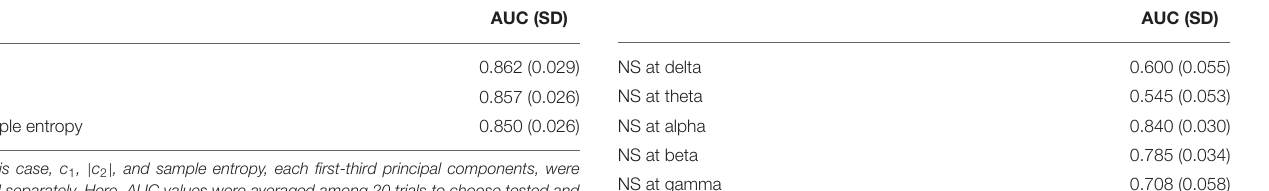
TABLE 5 | AUC for the NS of the PLI. In this case, the NS of the PLI was used separately for each of the first-third principal